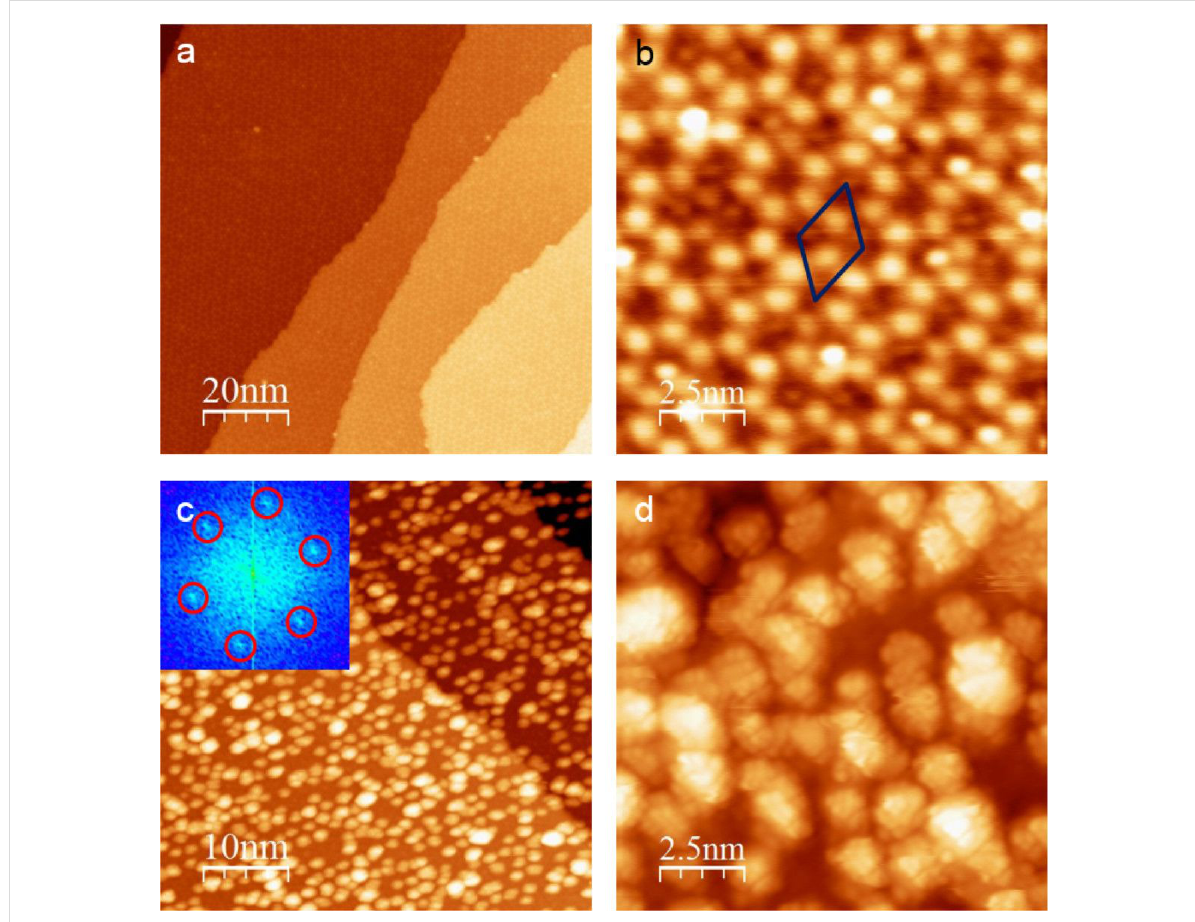
Figure 2: STM images of the w’-TiO x phase grown on Pt 3 Ti(111): (a) An overview image (100 × 100 nm; U B = 2.50 V; I T = 62 pA) of the clean oxide phase. The oxide film covers the entire surface. (b) A high-resolution scan (50 × 50 nm; U B = 1.57 V; I T = 100 pA) of the w’-TiO x phase with a marked unit cell. The bright spots represent the coincidence points in the moiré structure caused by the interplay between the oxide layer and the substrate. (c) The w’-TiO x phase after deposition of W 3 O 9 ( ≈ 0.6 monolayer coverage; 50 × 50 nm; U B = 1.57 V; I T = 58 pA). The clusters show a hexagonal arrangement (see marked spots in the FFT inset) with a slight tendency to form agglomerations. (d) A submolecular resolution scan (7.7 × 7.7 nm; U B = 1.00 V; I T = 62 pA) of individual W 3 O 9